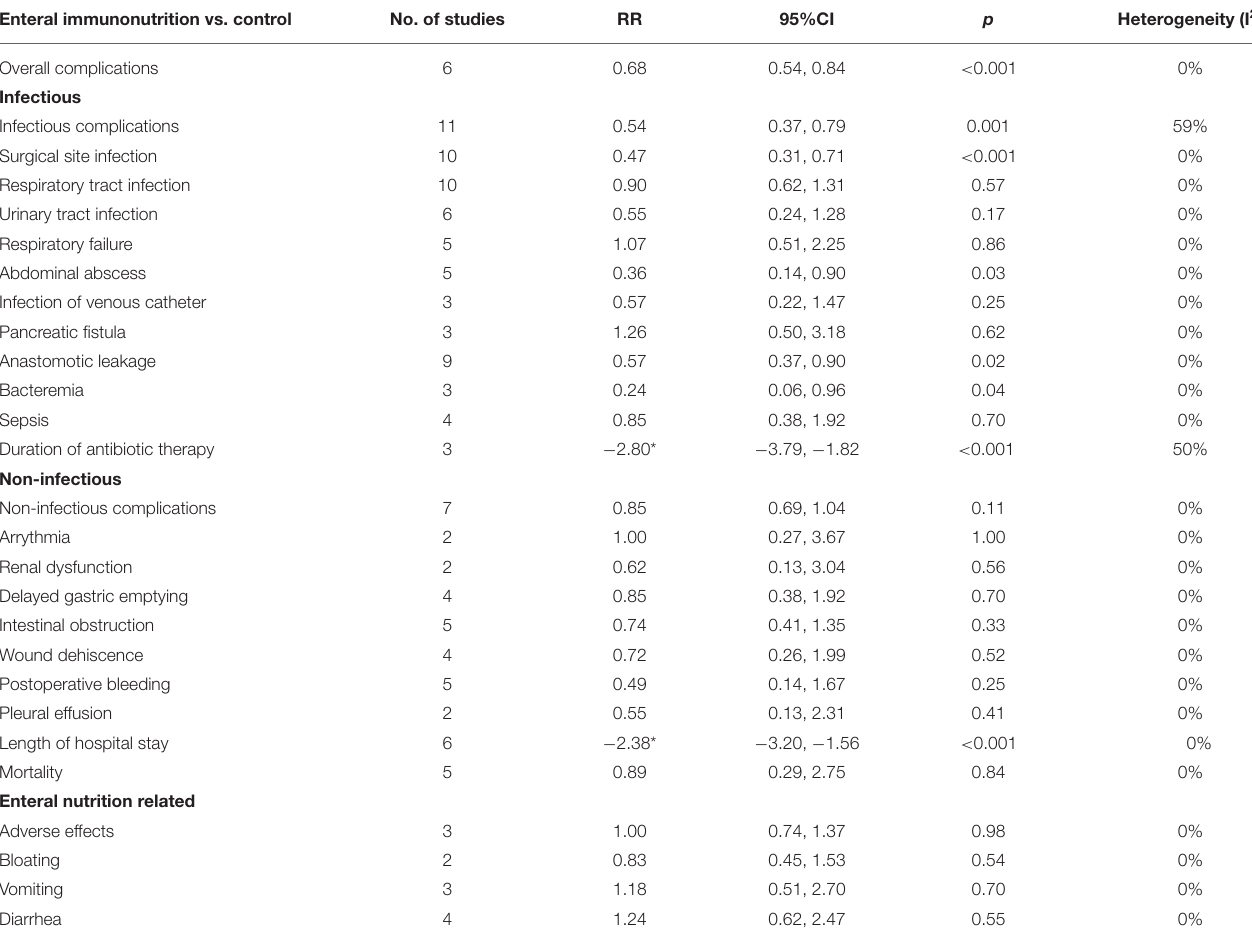
TABLE 3 | Analysis of perioperative nutrition outcomes. Enteral immunonutrition vs. control